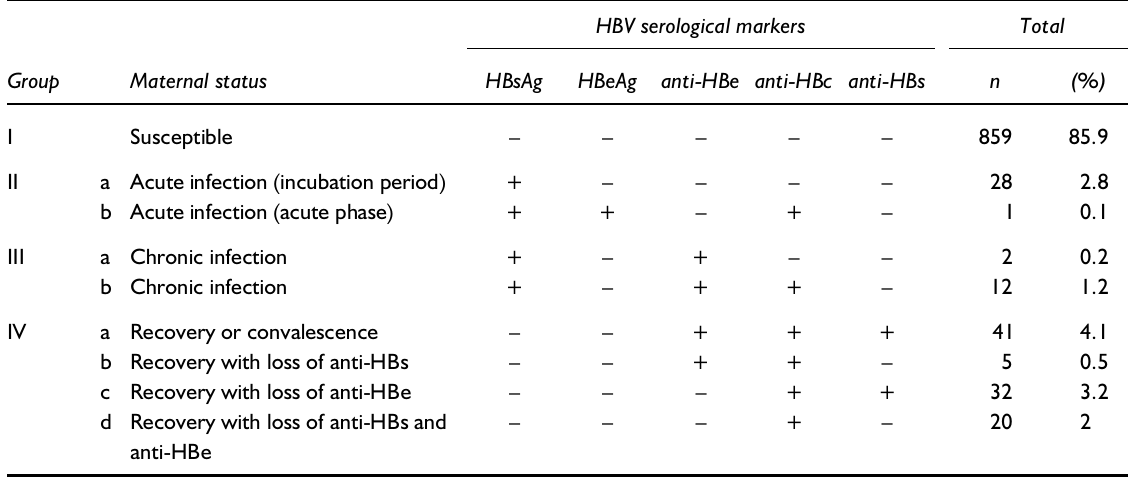
Table 2 Hepatitis B status of Jordanian pregnant